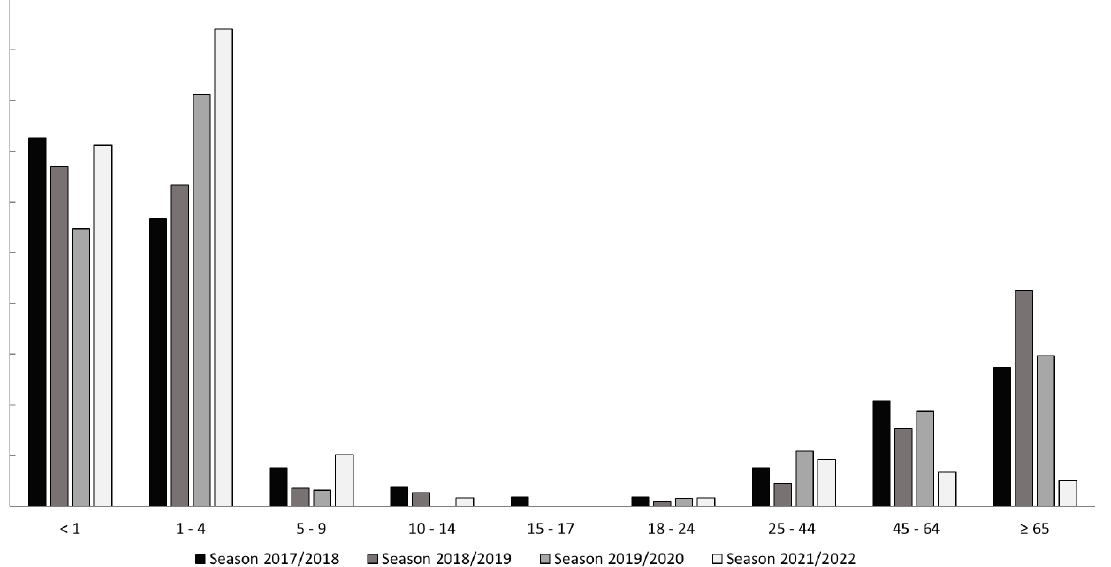
Figure 3. Relative distribution of RSV cases ( n = 796) by age. The bars represent the relative amount of cases detected in the indicated age group for each of the analyzed seasons.